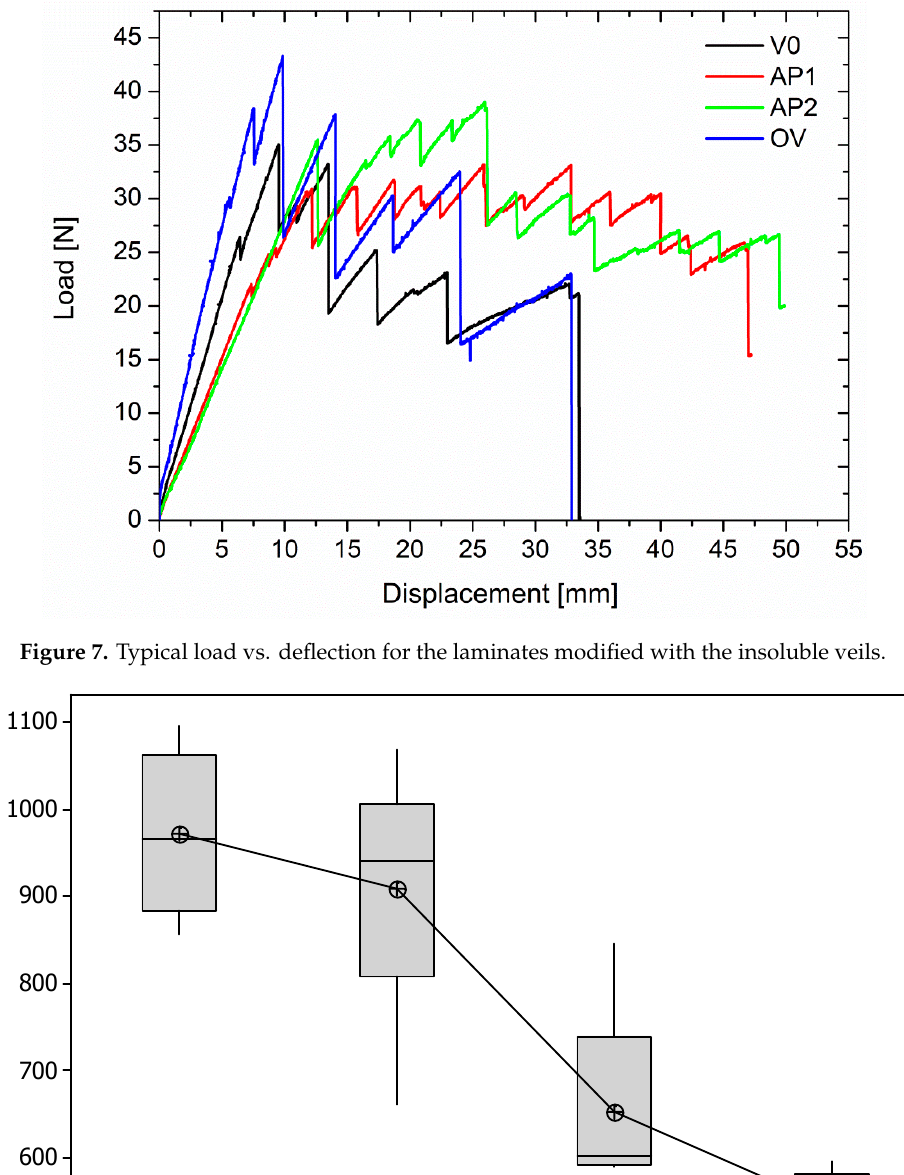
Figure 6. Typical load vs. displacement for the unmodified laminates.